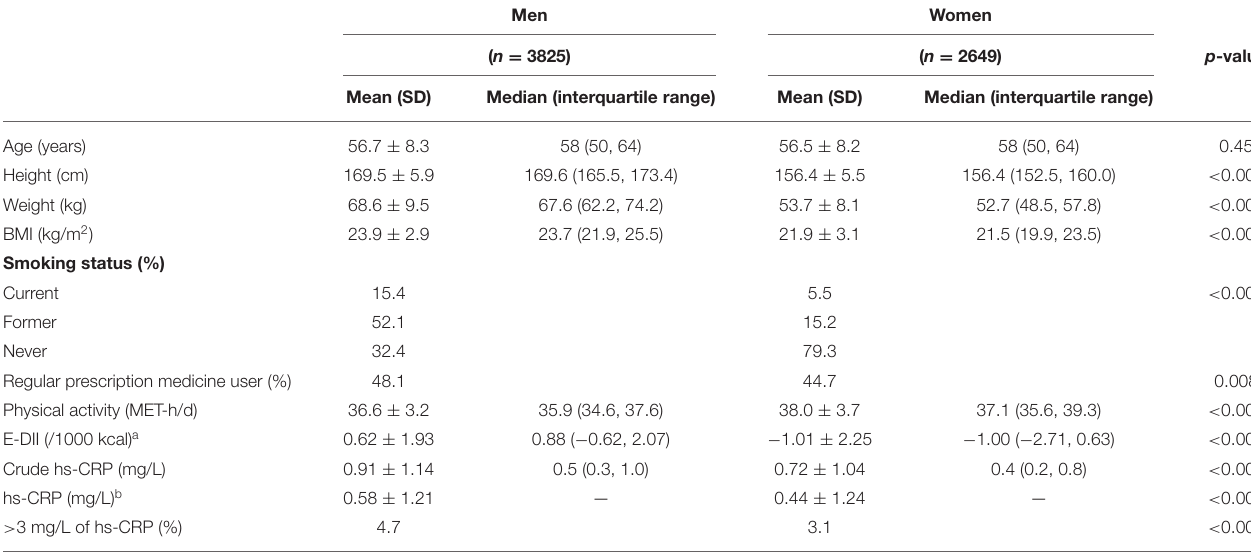
TABLE 1 | Characteristics of the volunteers of the cancer-screening program from May 2009 to December 2013 at National Cancer Center